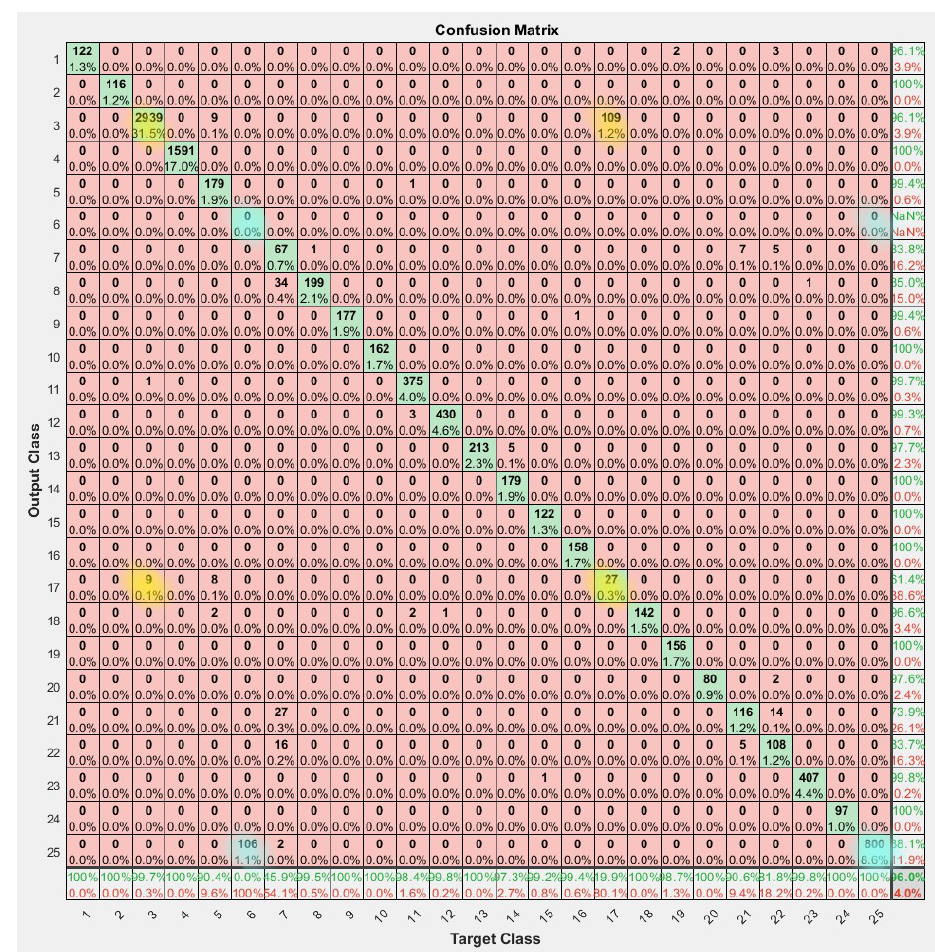
Figure 6. Confusion matrix produced by a simple